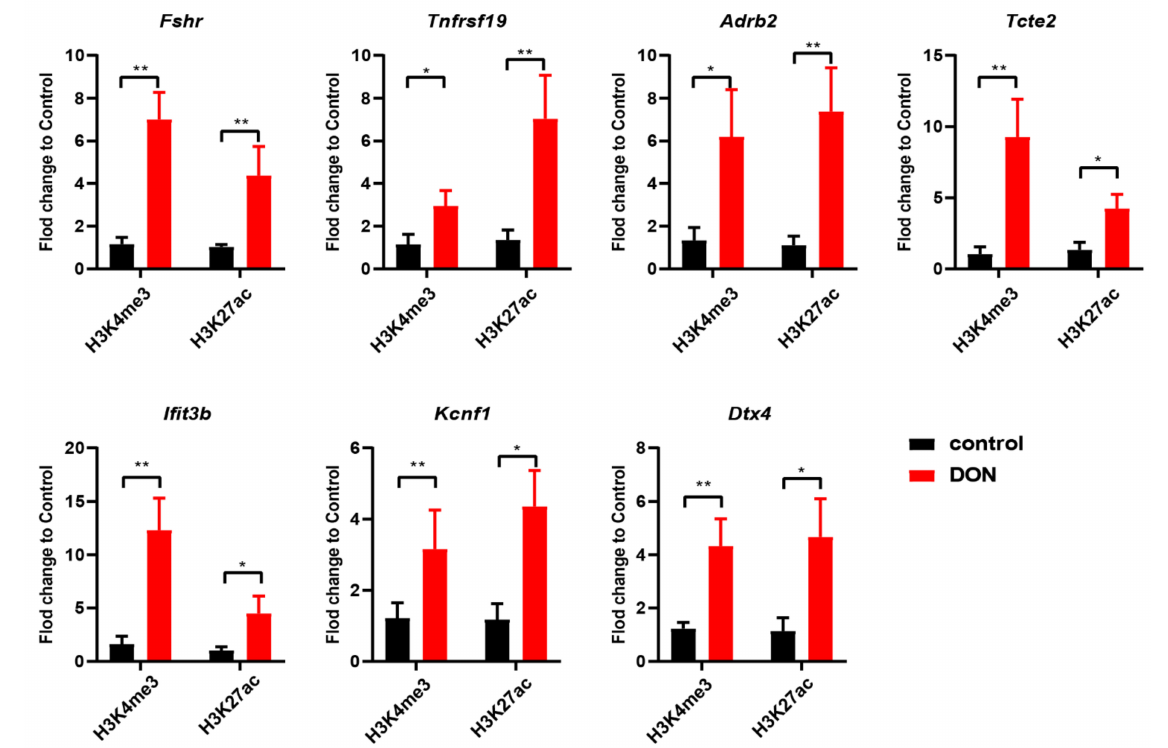
Figure 5. Histone modifications at the accessible chromatin regions. The fold changes of histone H3K4me3 and H3K27ac are determined by ChIP-qPCR in chromatin-accessible regions of Fshr, Tnfrsf19, Adrb2, Tcte2, Ifit3b, Kcnf1, and Dtx4. Each bar represents the mean ± SD, n = 3. * p < 0.05 and ** p < 0.01 compared with the control group ( t -test).